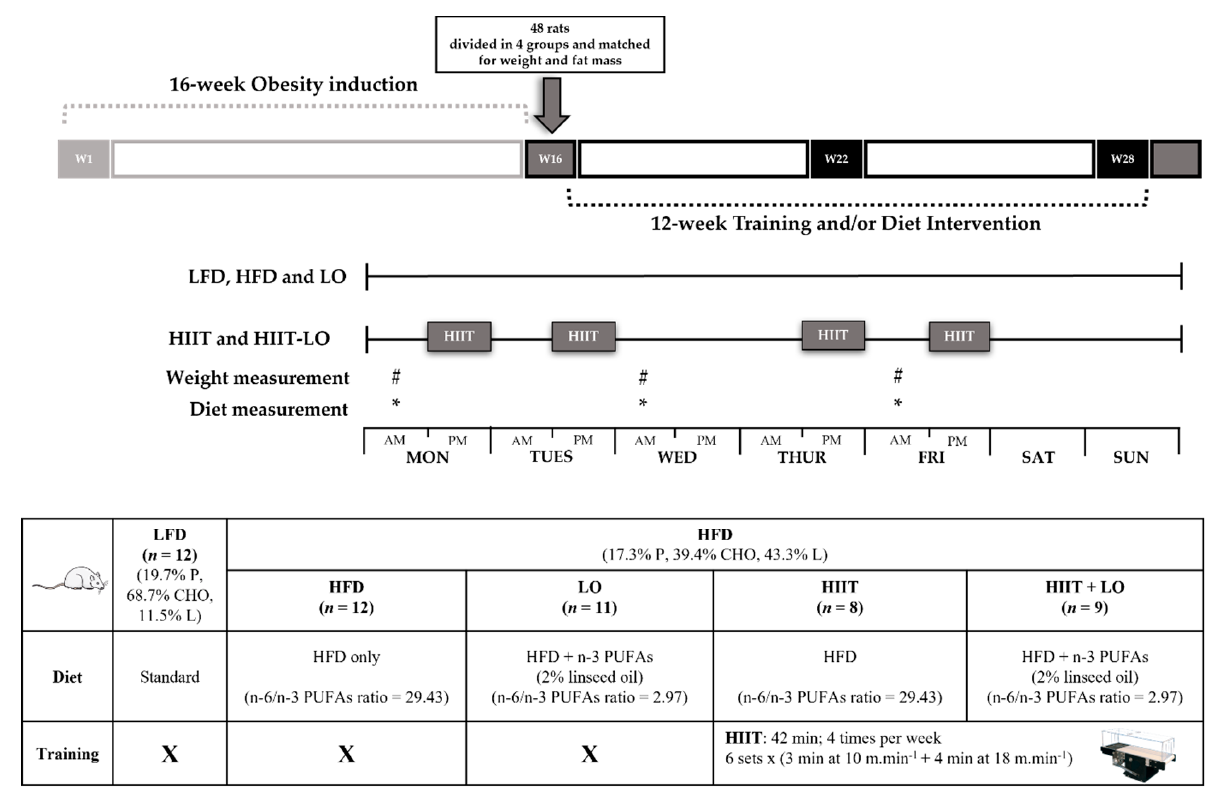
Figure 1. Experimental design of the study. Phase 1: rats were randomly assigned in two groups: LFD ( n = 12) and HFD ( n = 48) for 16 weeks. Phase 2: rats of the HFD group were divided in four groups ( n = 12/group) matched for weight and fat mass: HFD, LO, HIIT, and HIIT + LO for 12 weeks. LFD: low-fat diet, HFD: high-fat diet, LO: linseed oil, HIIT: high-intensity interval training, PUFAs: polyunsaturated fatty acids, P: proteins, CHO: carbohydrates, L: lipids, W: weeks, #: weight measurement, *: Diet measurement.